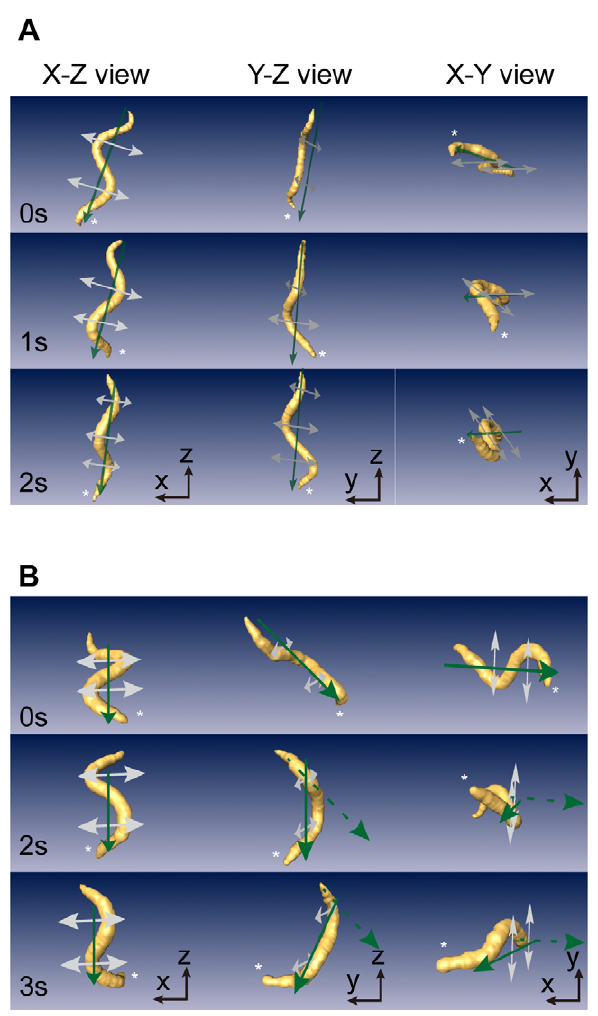
Figure 4. Volume-rendered images in three views. (A) 3-D posture of a worm showing bends in various directions (gray arrows) with only slight changes in the moving direction (green arrow) during crawling. (B) 3-D posture of another worm showing a significant change in the moving direction (green arrow). The asterisk in each image indicates the head of the worm.